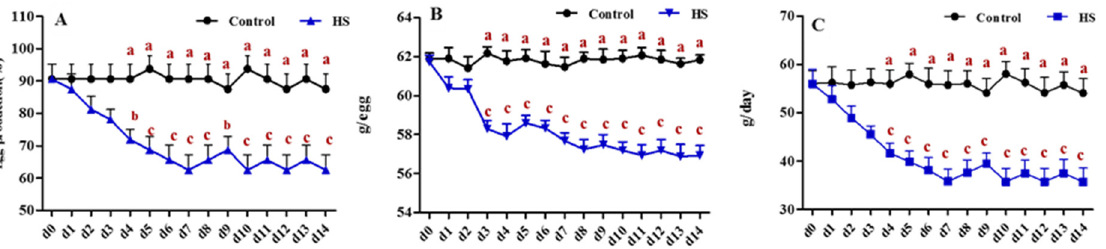
Figure 1. Effect of heat stress on the performance of laying hens. ( A ) Egg production, measured as percentages of laying hens/total hens. ( B ) Average egg weight of laying hens. ( C ) Egg mass, measured as g per egg produced/hen/D, on the day before heat stress (d0) and on each heat-stressed day (d1–d14) in control or stressed (HS) hens. The mean ( ± SEM) of 8 replicates, with each replicate containing 4 hens. Values with different letters are significantly different ( p <